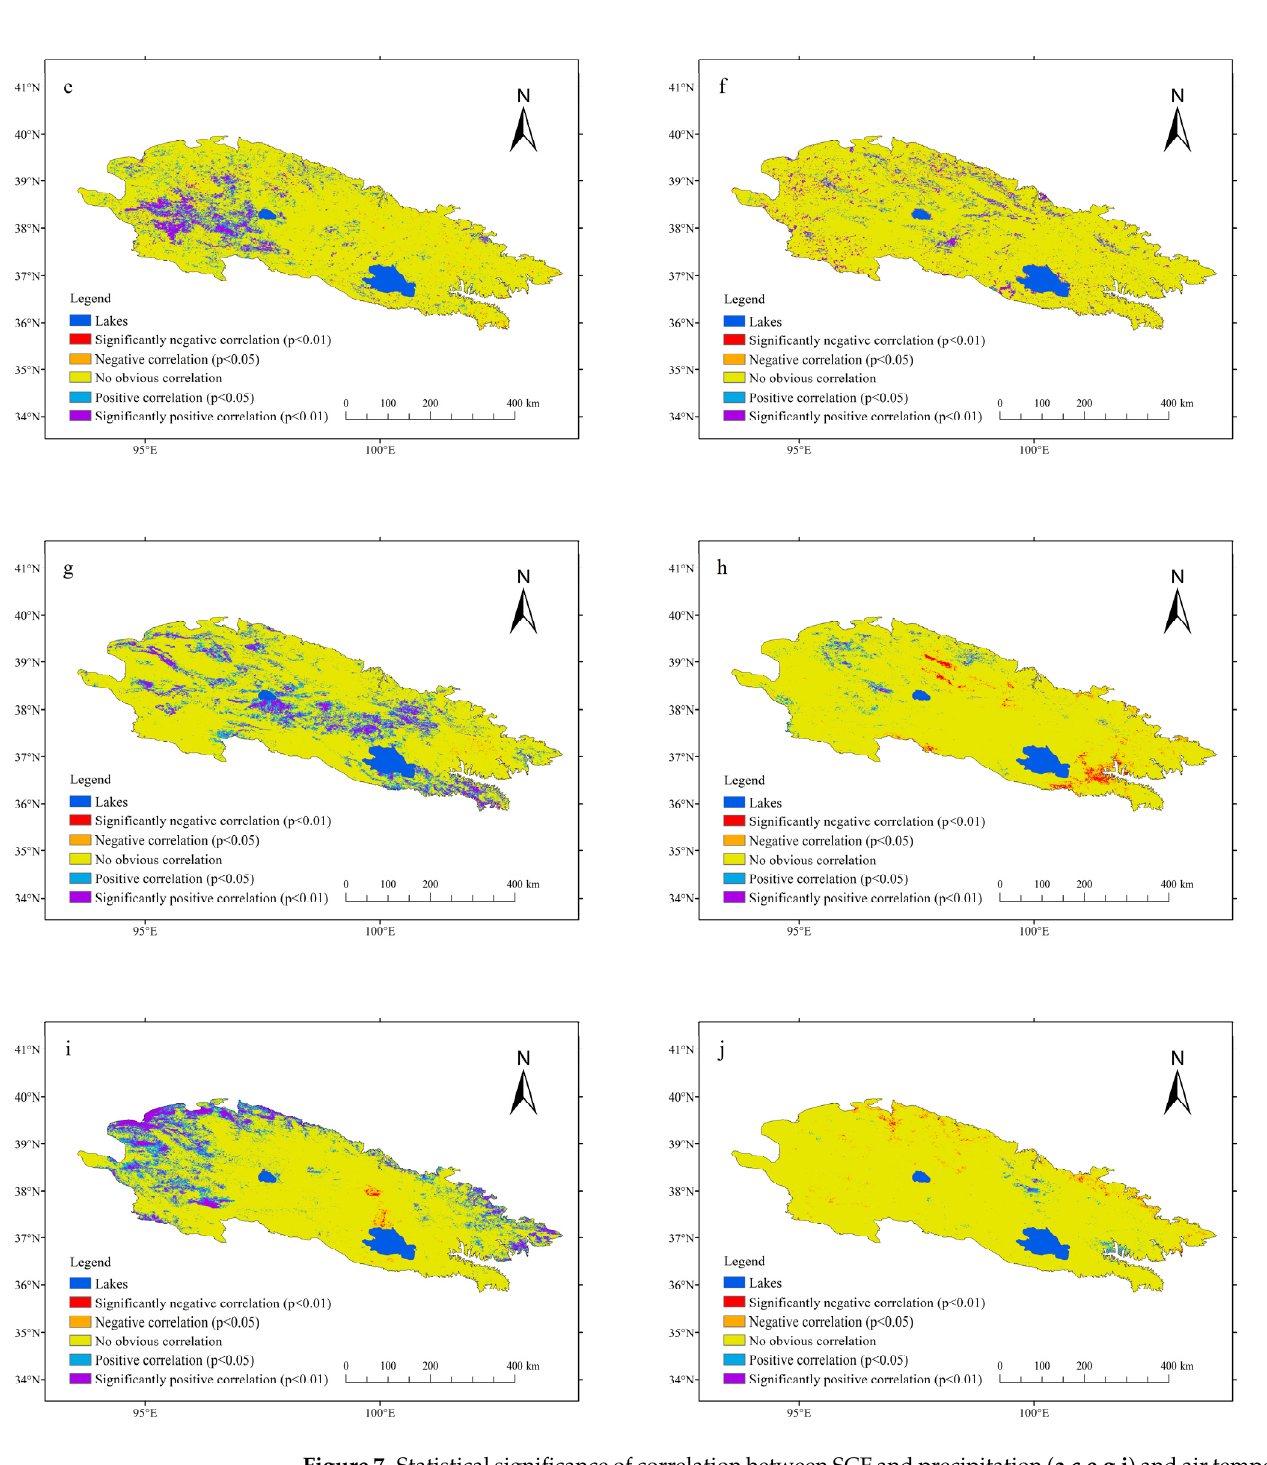
Figure 7. Statistical significance of correlation between SCF and precipitation ( a , c , e , g , i ) and air tem- perature ( b , d , f , h , j ) during 2000–2020. ( a , b ) spring; ( c , d ) summer; ( e , f ) autumn; ( g , h ) winter; ( i , j ) an-